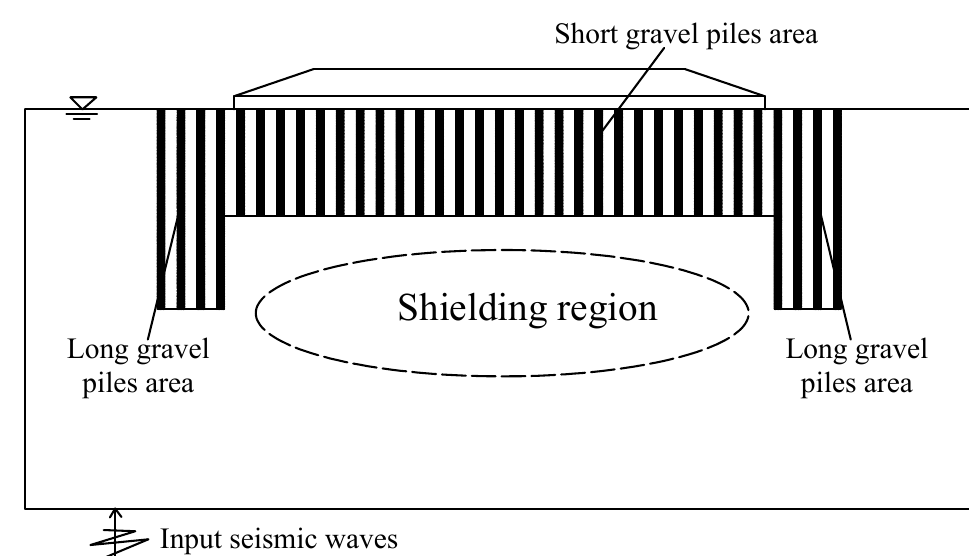
Figure 13. Shielding region and shielding effect.